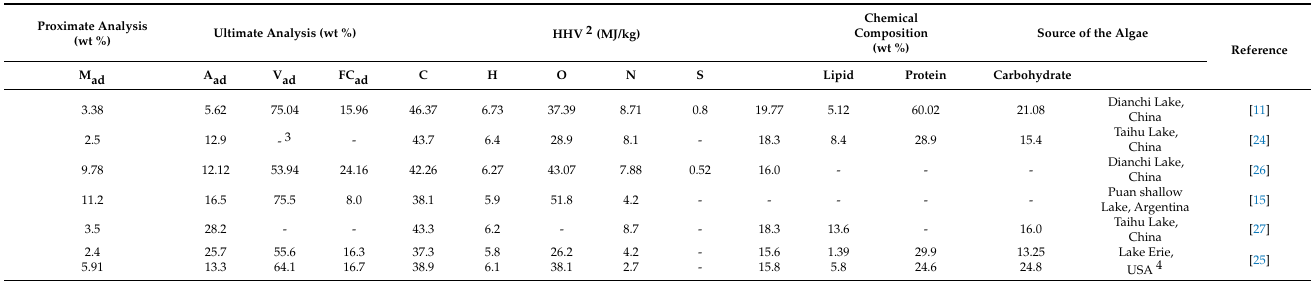
Table 1. Compositions of bloom-forming algae from water blooms 1